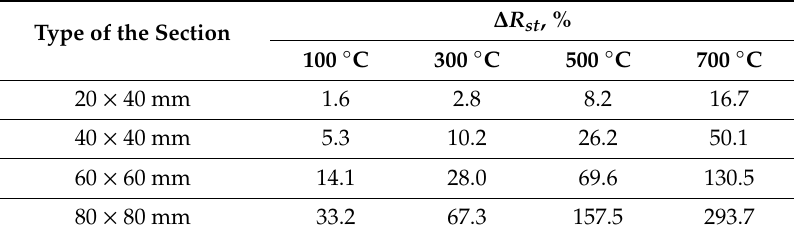
Table 1. The values of the ∆ R st parameter for individual sections for chosen temperatures. Type of the Section